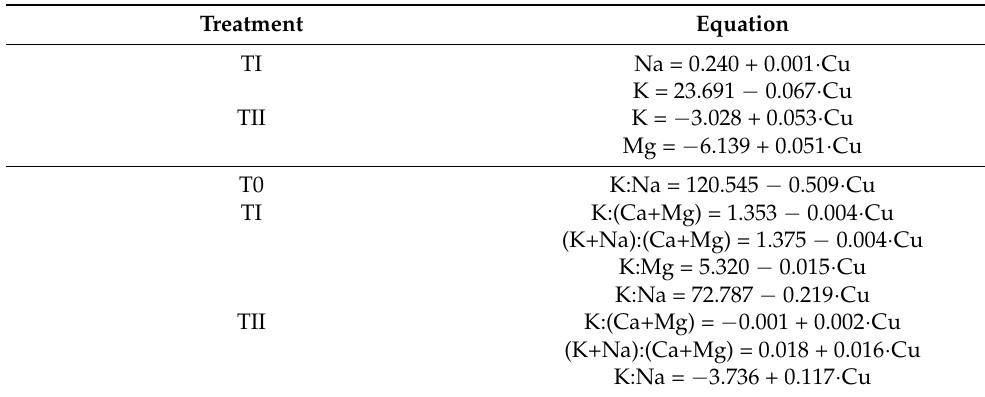
Table 4. Regression equations between Cu in soil (T0–TII) and the amount of macronutrients in oat and between Cu in soil and nutrient ratios in